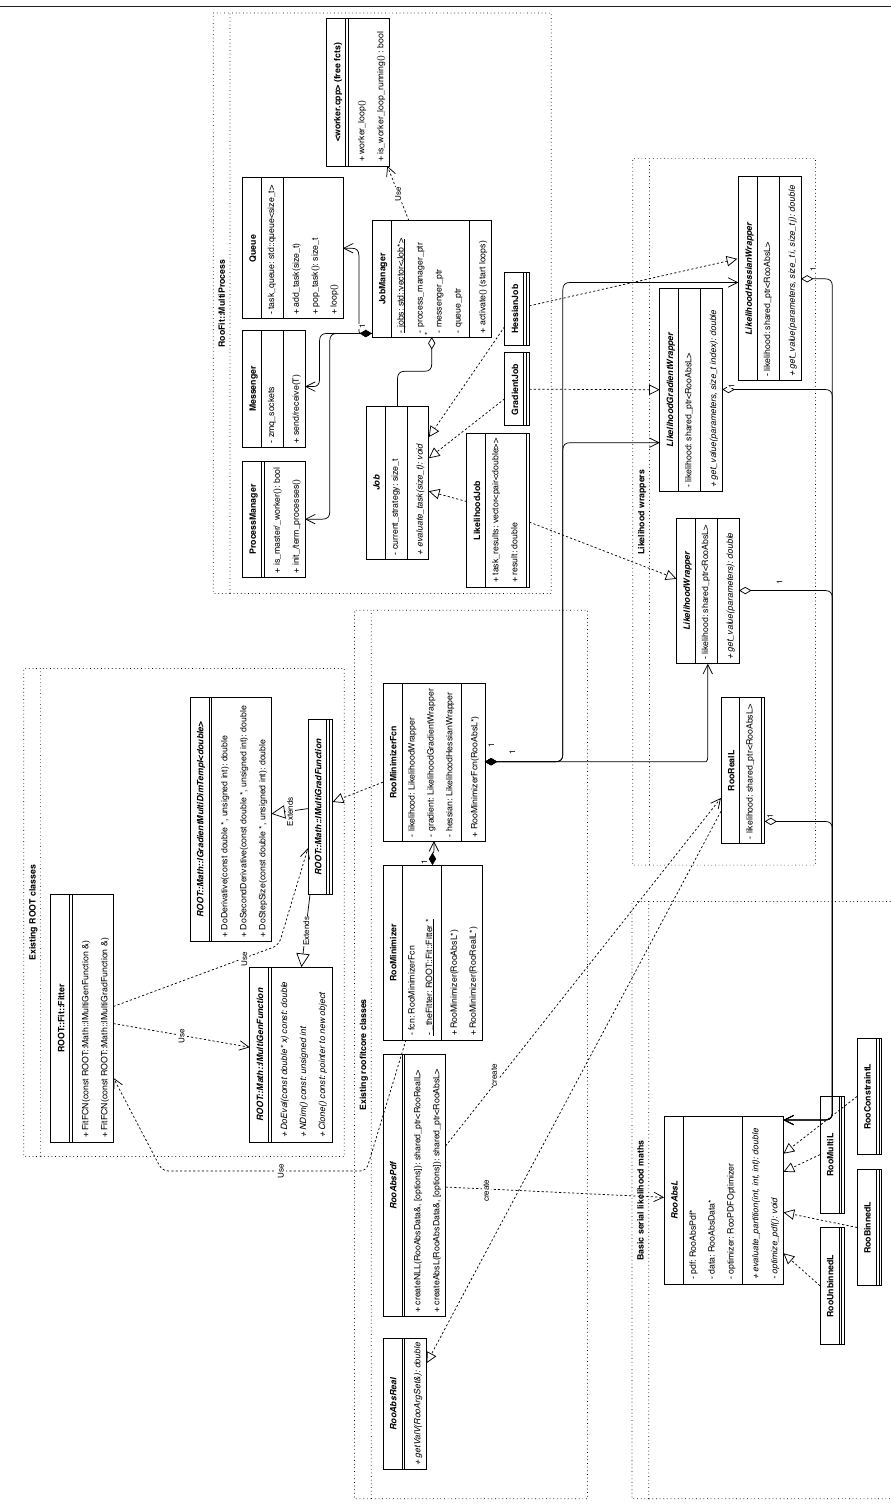
Figure 5: UML class diagram of the MultiProcess classes and the new likelihood classes and their connections to existing